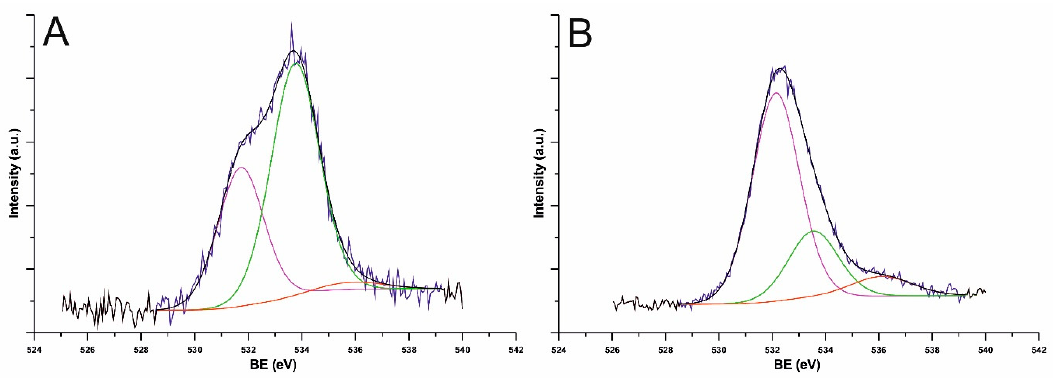
Figure 7. O-1s region X-ray photoelectron spectroscopy (XPS) signals and deconvoluted peaks for O -arylated Nanocyl NC7000 TM MWCNTs modified via reaction of chlorinated nanotubes with phenol ( A ) and 1,3,5-trihydroxybenzene ( B ).